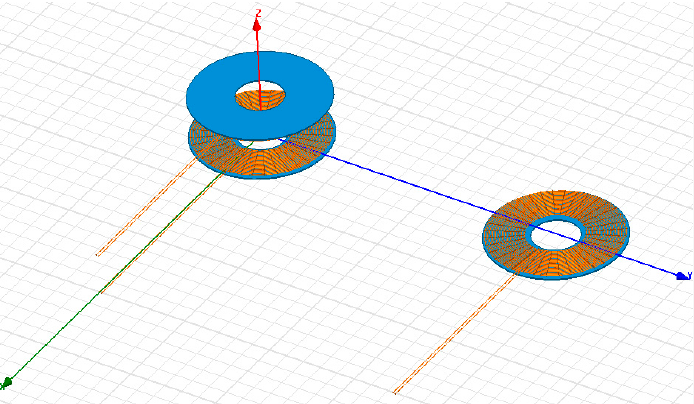
Figure 8. Energies 2019 , 12 , x FOR PEER REVIEW